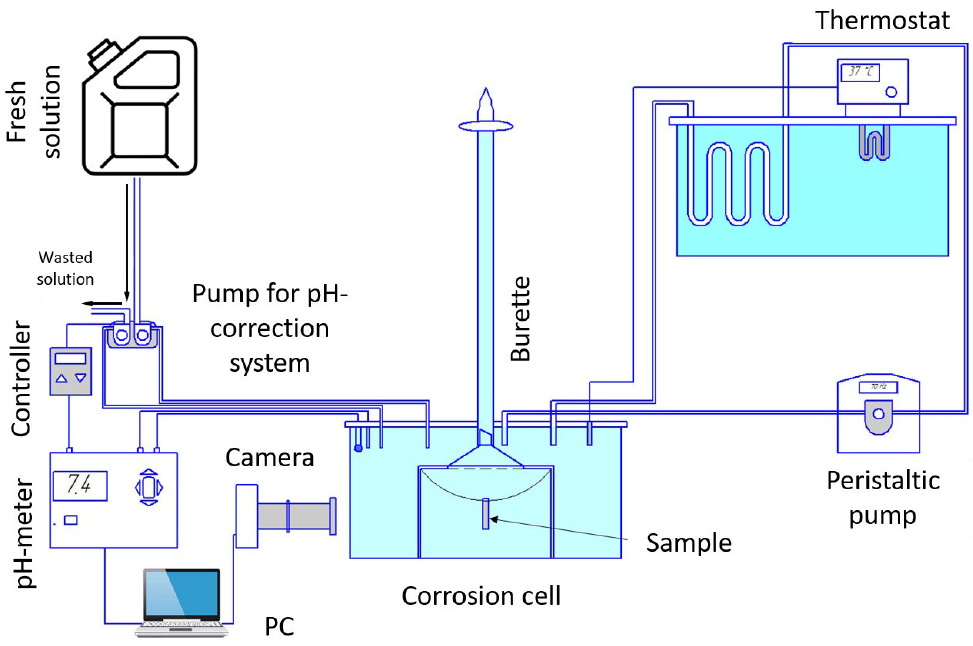
Figure 6. Immersion test setup with automated pH adjustment and hydrogen storage measurement, controlled circulation of the corrosive media, thermal stabilization, and a video observation system.